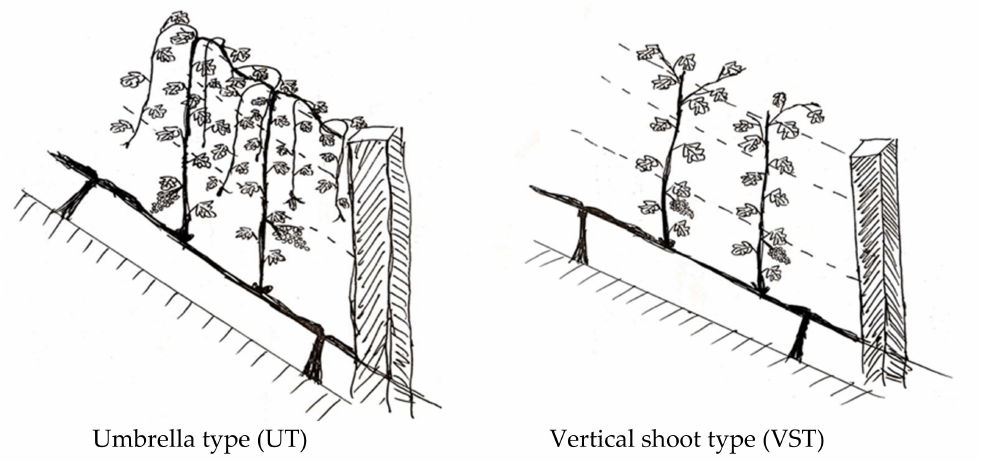
Figure 1. Diagram of different canopy